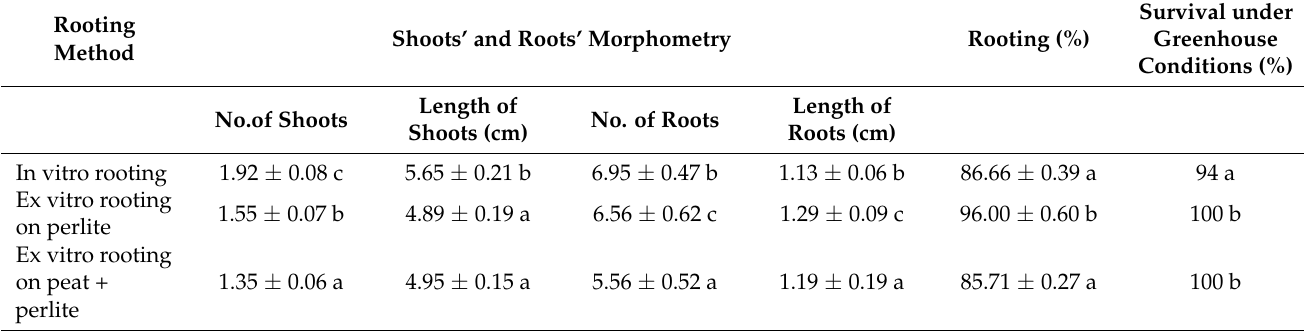
Table 1. Rooting and acclimatization data recorded in micropropagated plants of H. lupulus cv. Cascade. Rooting Shoots’ and Roots’ Morphometry Rooting (%) Greenhouse